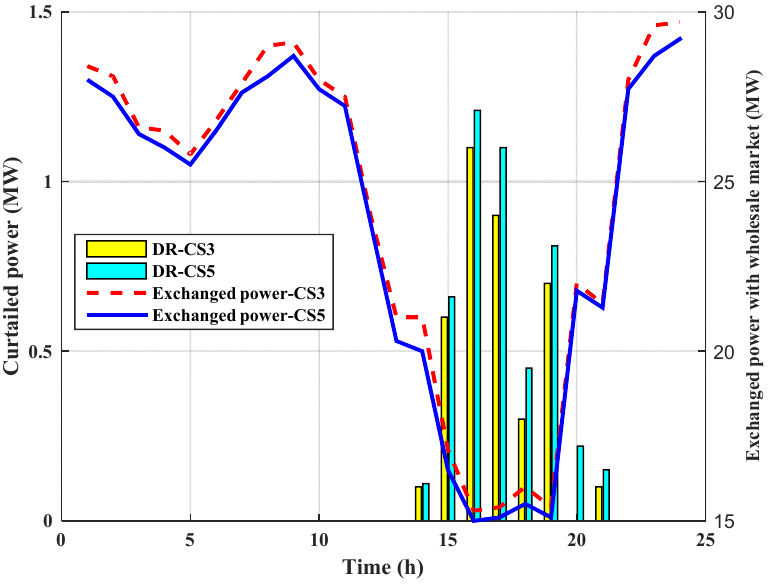
Figure 8. Exchanged power with the wholesale market and the curtailed power through DRPs in CS3 and CS5. Table 7. Simulation results of different CSs for the proposed MILP ‐ stochastic MPC model.